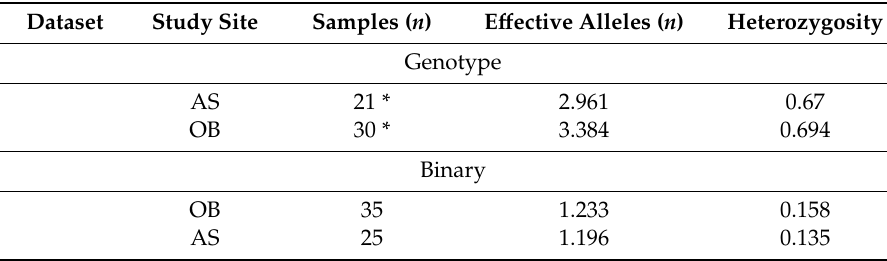
Table 3. Genetic diversity of the microsatellite markers.